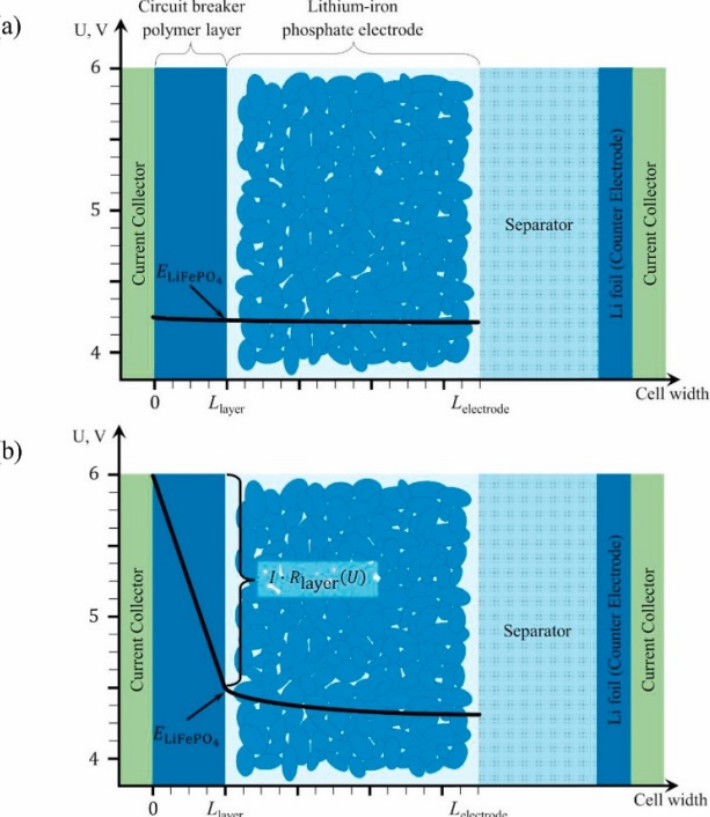
Figure 13. Schematic representation of the half-cell configuration with protective layer in ( a ) normal operation conditions and ( b ) at overcharge [116]. Reprint with permission from [116].; Copyright 2021, Elsevier.